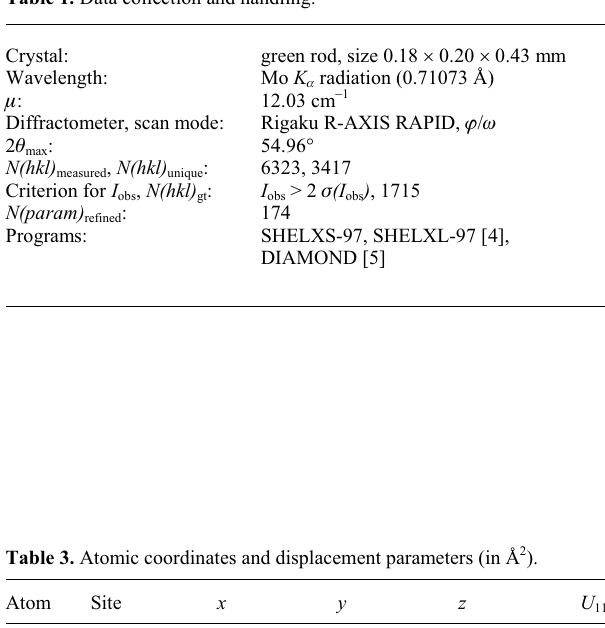
Table 2. Atomic coordinates and displacement parameters (in Å 2 ) . Table 1. Data collection and